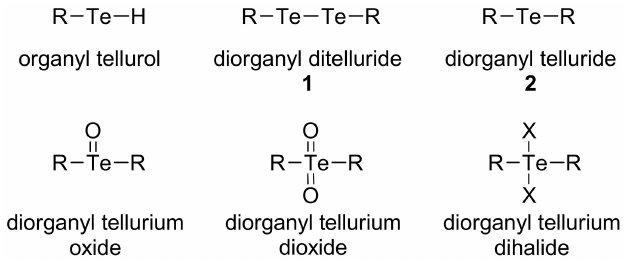
Figure 1. Types of organyl tellurium